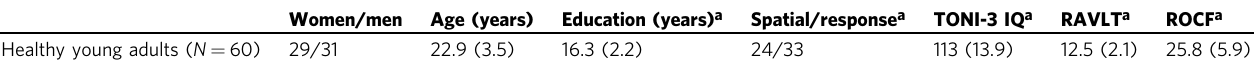
Table 1 Participant demographics, navigation strategies, and performance on neuropsychological